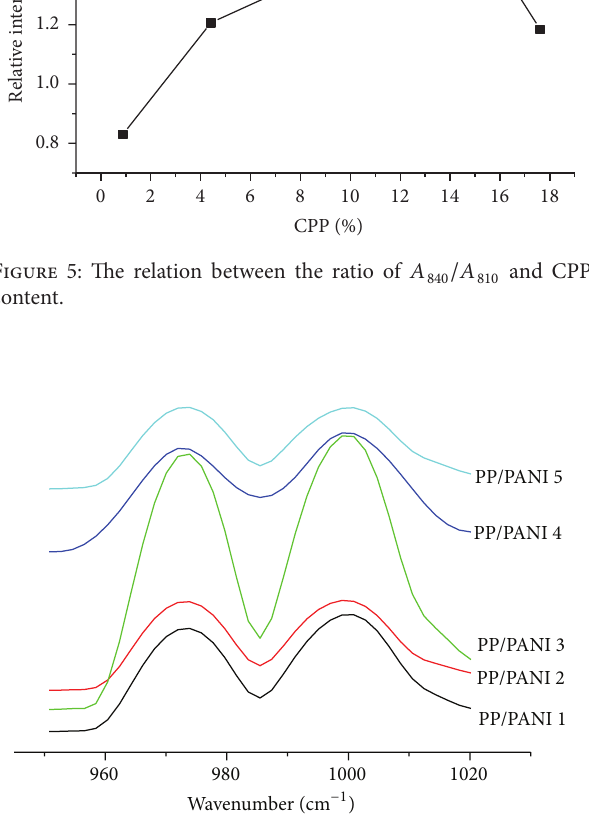
Figure 6: FTIR spectra of the PP/CPP/PANI composites with different CPP concentrations (950–1020 cm −1 ).